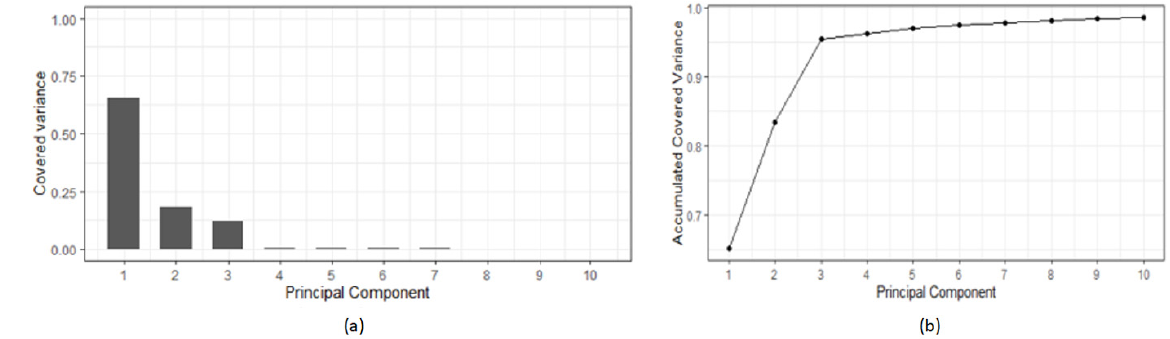
Figure 4. Principal component analysis results of patient P05 data: ( a ) Covered variance; ( b ) accumulated variance.